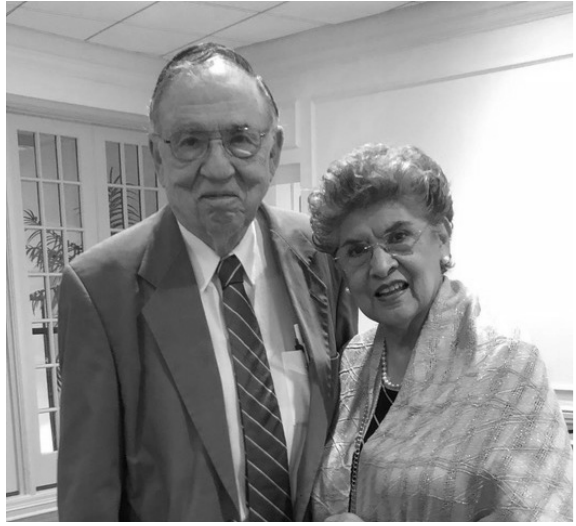
Figure 2. Maria Antonietta and Manuel Philip Berriozábal. ©M.A. and M.P.